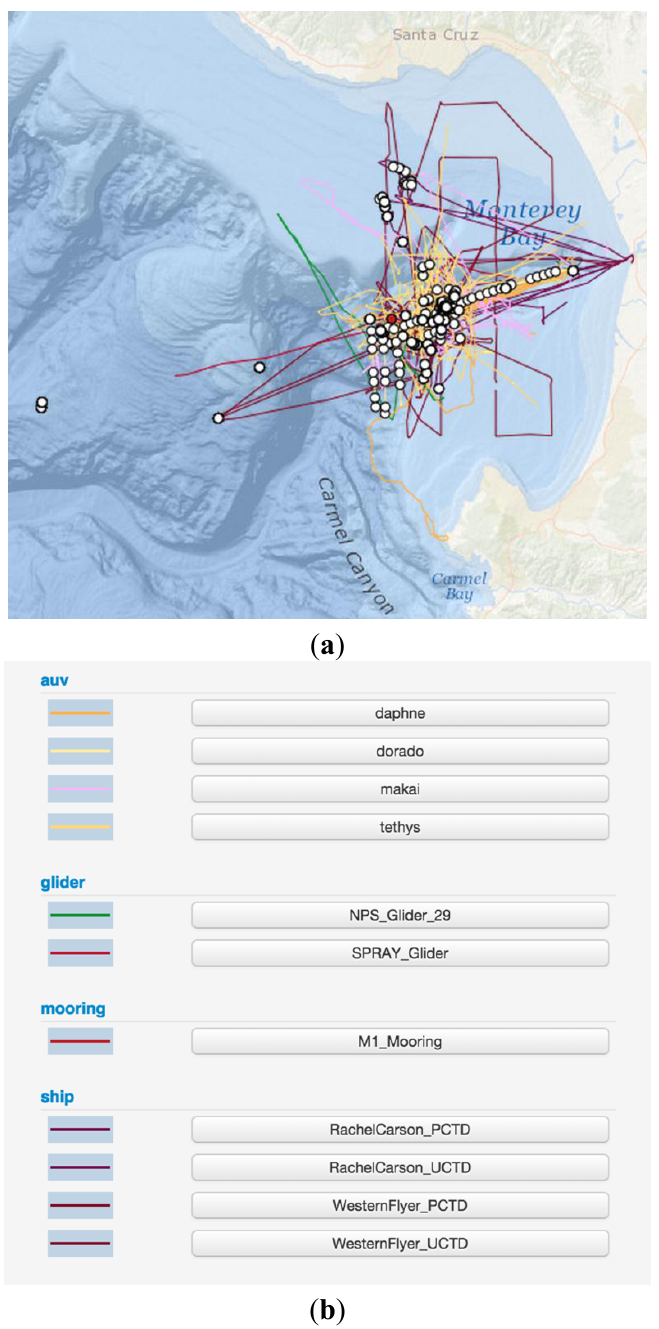
Figure 3. CANON-ECOHAB-September 2014 experimental data in STOQS (Copyright 2015 MBARI [30]). ( a ) is the map of the vehicle tracks and ( b ) describes the annotation of lines. The red circle is the M1 mooring observation position, and the white circles denote the sampling positions at different